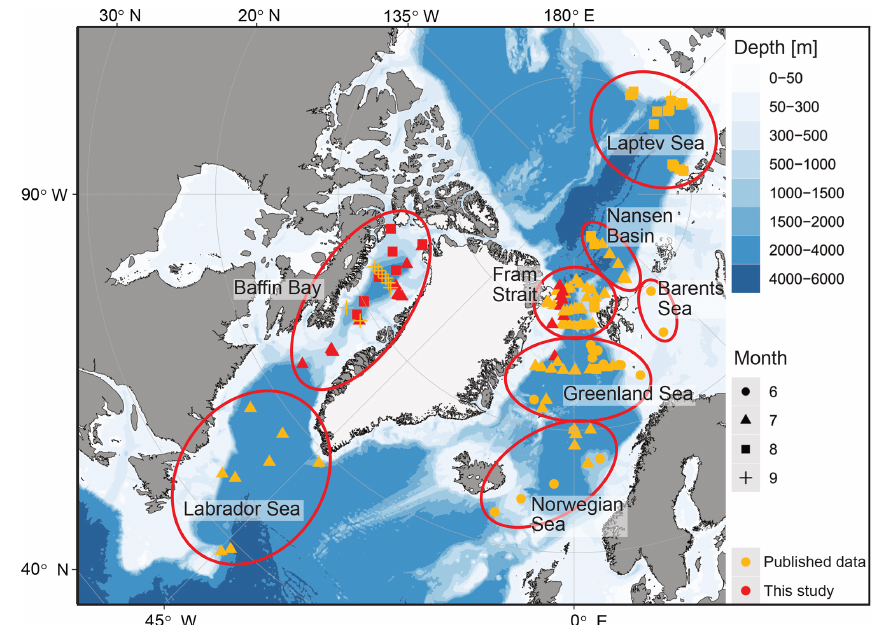
Figure 1. Overview of the research area with different regions (circled in red) sampled during different research cruises. Published data (orange) and new data (red) used in this study, as well as the sampling periods (symbols), are marked. Land and glacier polygons from Natural Earth Data (CC0) and bathymetry from Amante and Eakins (2009), using ggOceanMaps in R (Vihtakari,